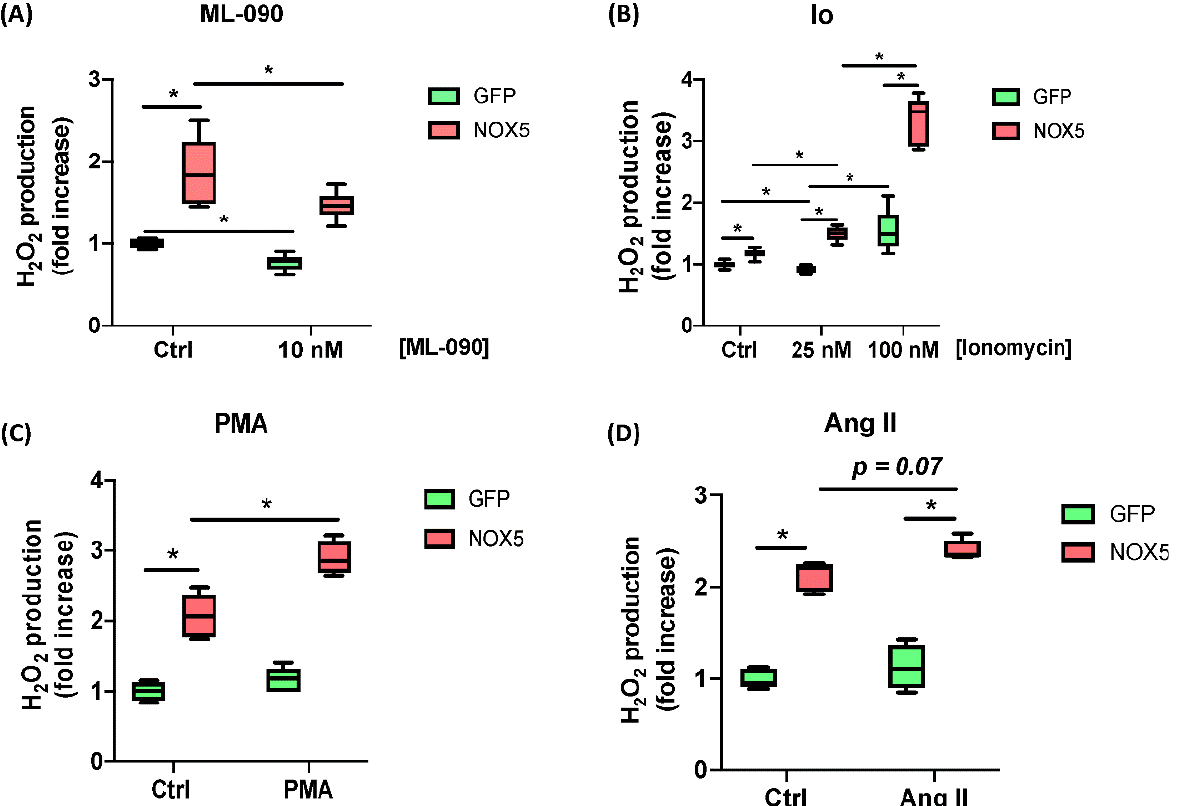
Figure 2. ROS production characterization of hCMEC/D3 cells infected in response to different stimuli and inhibitors. ( A ) H 2 O 2 production after 10 nM ML-090 inhibition. ( B ) H 2 O 2 production after 25 and 100 nM Ionomycin (Io) stimulation. ( C ) H 2 O 2 production after 100 nM PMA stimulation. ( D ) H 2 O 2 production after 100 nM Ang II stimulation. ( n = 6). GFP : GFP-infected hCMEC/D3 cells; NOX5: NOX5- β -infected hCMEC/D3 cells. * p < 0.05 vs. indicated group. Data presented as mean ± SEM.